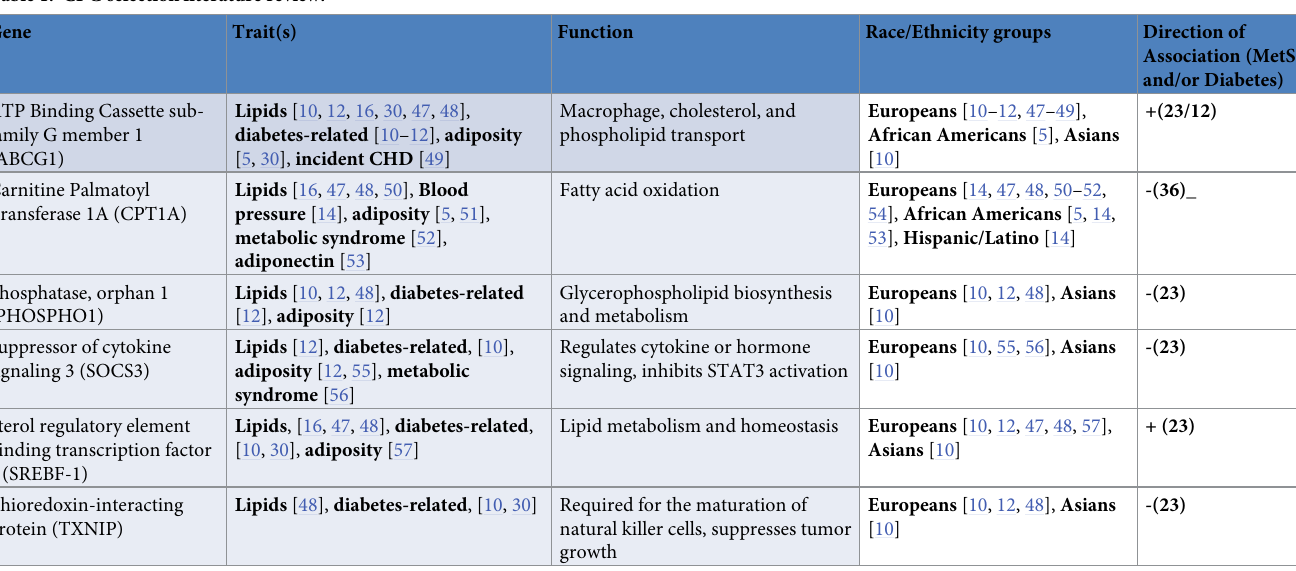
Table 1. CPG selection literature